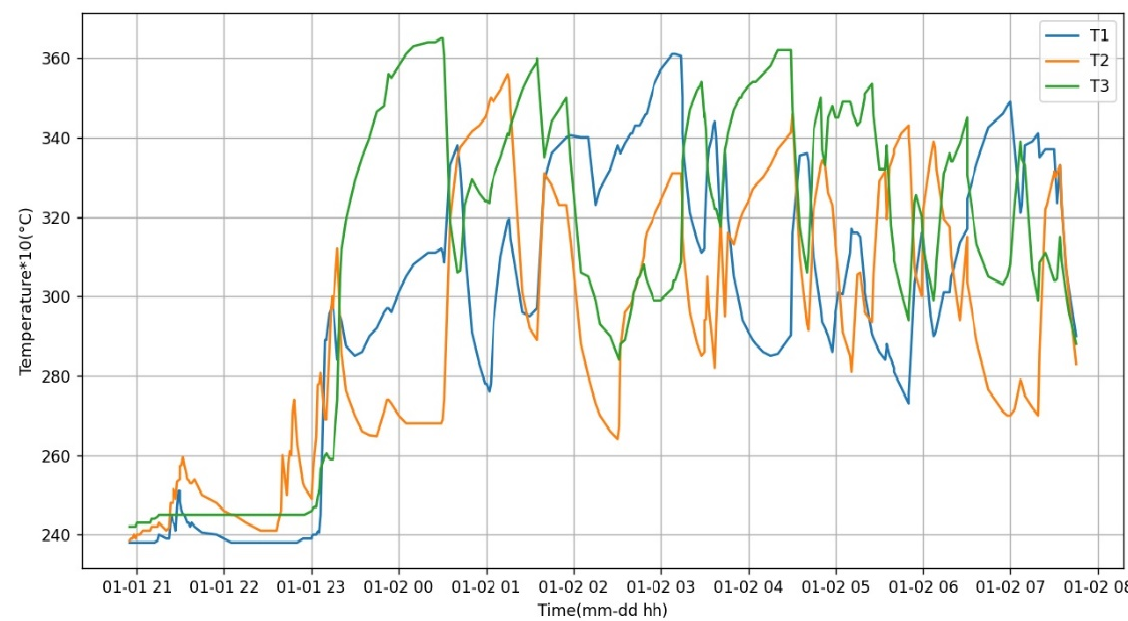
Figure 13. The measurement of temperature for the smart pillow.